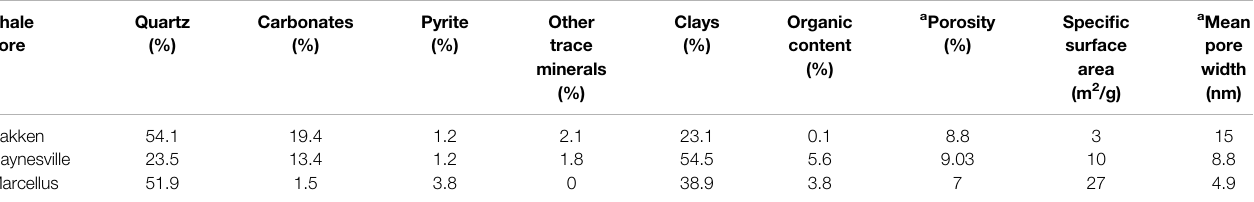
TABLE 2 | Comparison of compositional and pore structural properties for the Bakken, Haynesville and Marcellus shale samples (Chakraborty et al., 2020) Shale